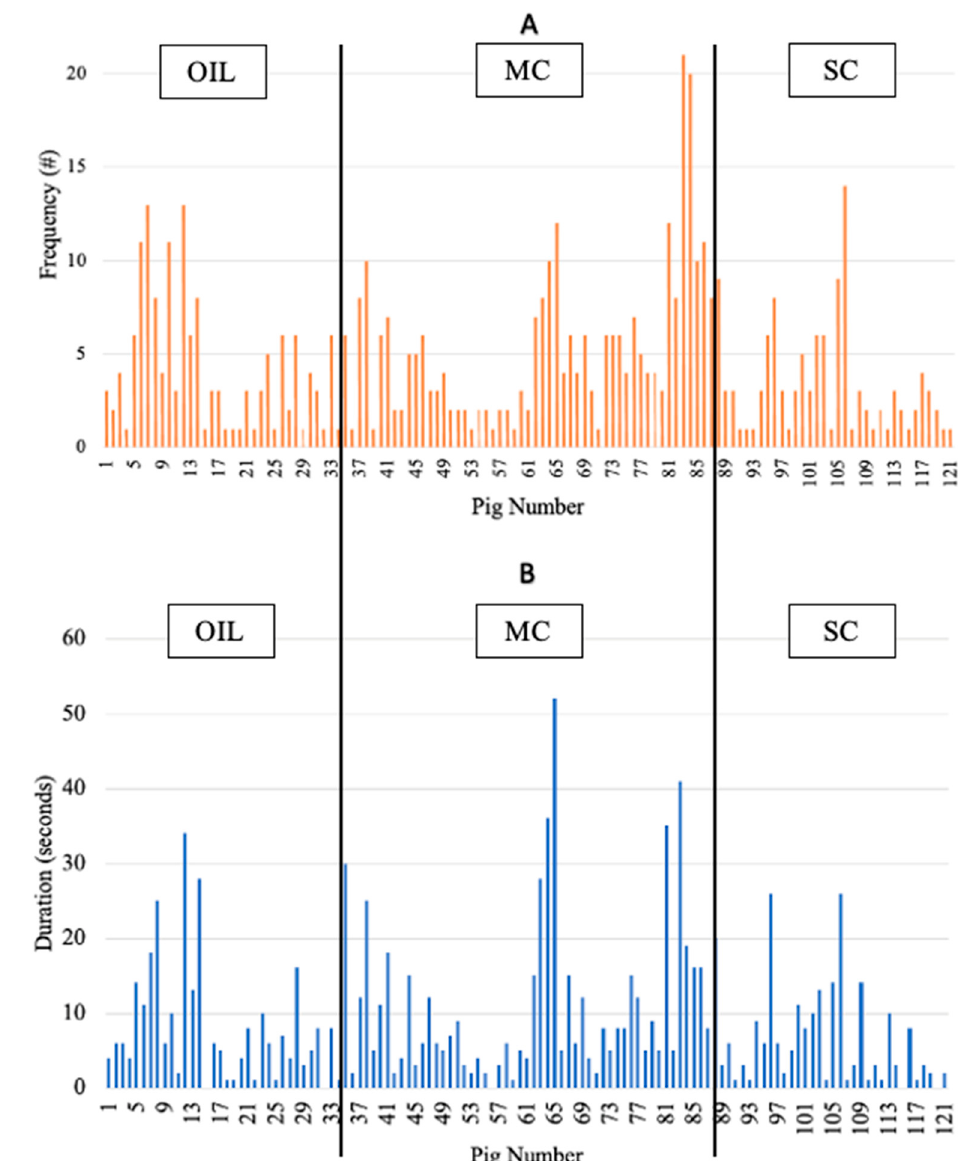
Figure 4. Descriptive measures of piglet individual variation in total frequency ( A ) and duration ( B ) of piglet purposeful investigations with environmental enrichment ropes on Day 2, the first day of placement. OIL = sunflower oil, MC = milky cheese, and SC = semiochemical.